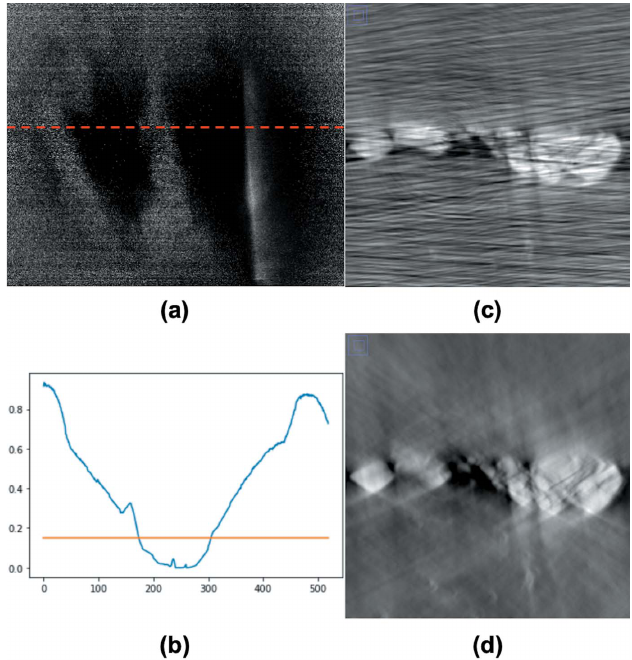
Figure 5 ( a ) The projection image of a battery electrode sample at an angle when the electrode is parallel to the X-ray beam. ( b ) The mean normalized value averaged along the row direction as a function of the projection angle index. The mean value drops close to zero in an angle range. ( c ) A reconstructed slice image with all the projection images over 180 (cid:5) angle range. The stripe lines are due to the low signals in the angle range. ( d ) The reconstructed slice image with the projection images except that in the angle range in which the mean values are lower than the threshold marked in ( b